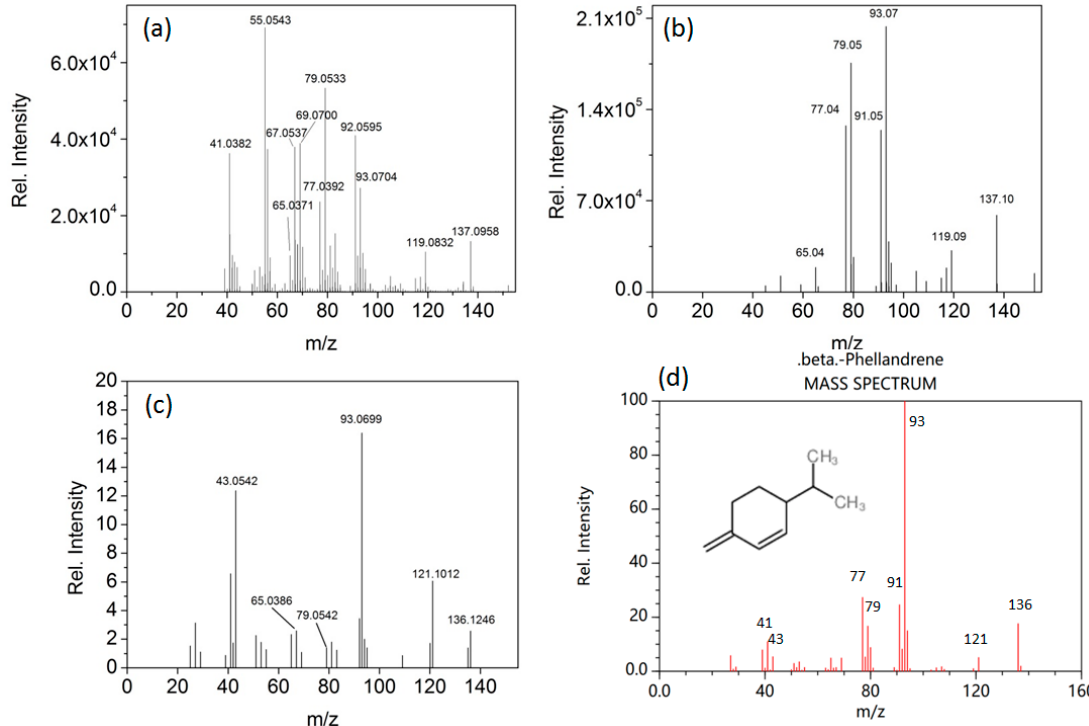
Figure 1. Example of β -Phellandrene detection in a blueberry wine sample ( a ) The average spectrum of β -Phellandrene extracted by conventional manual background subtraction; ( b ) the deconvoluted spectrum of β -Phellandrene. ( c ) β -Phellandrene spectrum from NIST library; ( d ) Predicted GC-MS Spectrum-GC-MS (Non-derivatized)-70 eV, Positive (HMDB0036081), obtained from The Human Metabolome Database (HMDB).